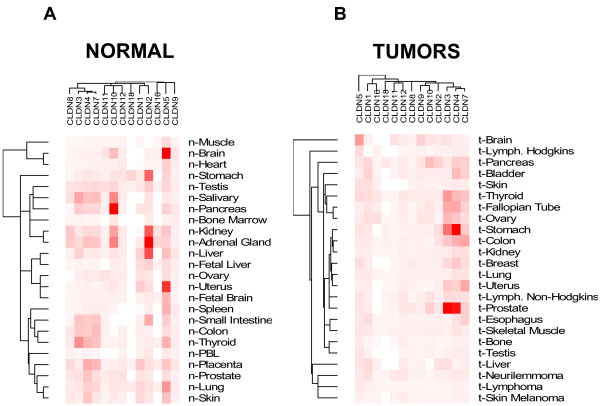
Real-time RT-PCR survey of CLDN gene expression in normal and neoplastic tissus. Expression data of 13 selected CLDN family members from 24 normal and 24 tumor tissue cDNAs. The dChip software was used to analyze and cluster the data. Clustering of the CLDN genes and the tissues were performed with distances based on 1-rank correlation and the centroid linkage method. Darker shades of red indicate higher CLDN expression.